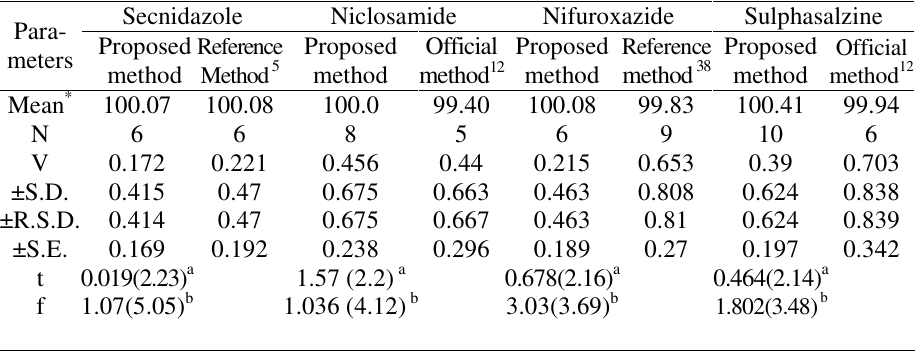
Table 3. Statistical analysis of results obtained by the proposed method compared with official 12 and reference methods 5, 38